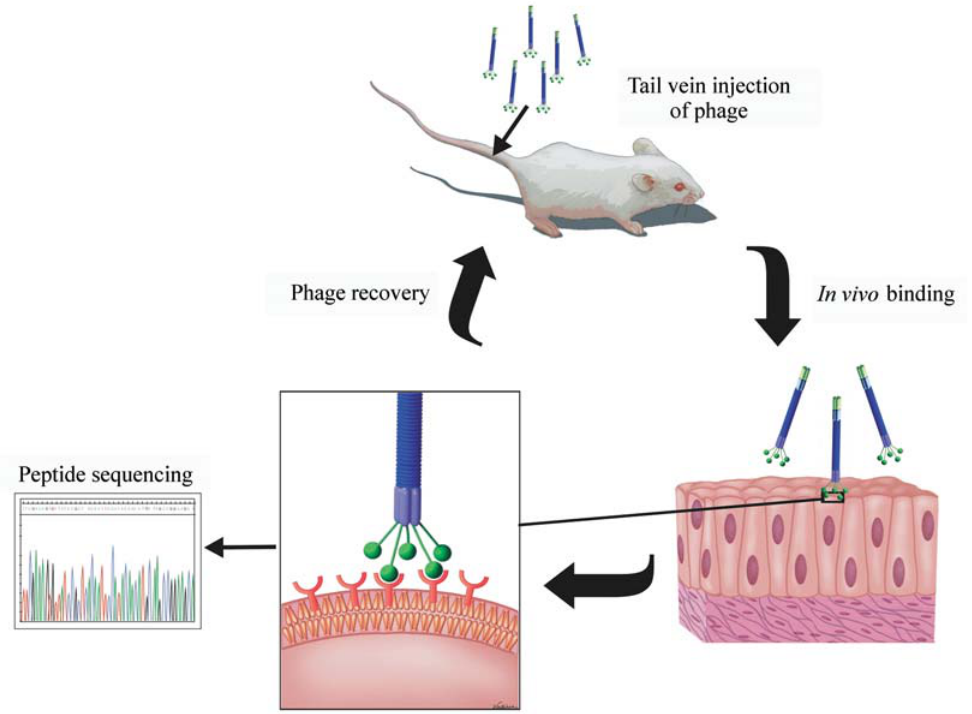
Figure2 - Invivo useofphagelibraries.Initiallythephagelibraryisinjectedinthecirculation.Next,phageisallowedtocirculateforminutesorhours(in thiscasewheninternalizedphagesaretoberecovered).Finally,afterdeepanesthesia,miceareeuthanizedandtheorgansaredissectedforphagerecovery and peptide